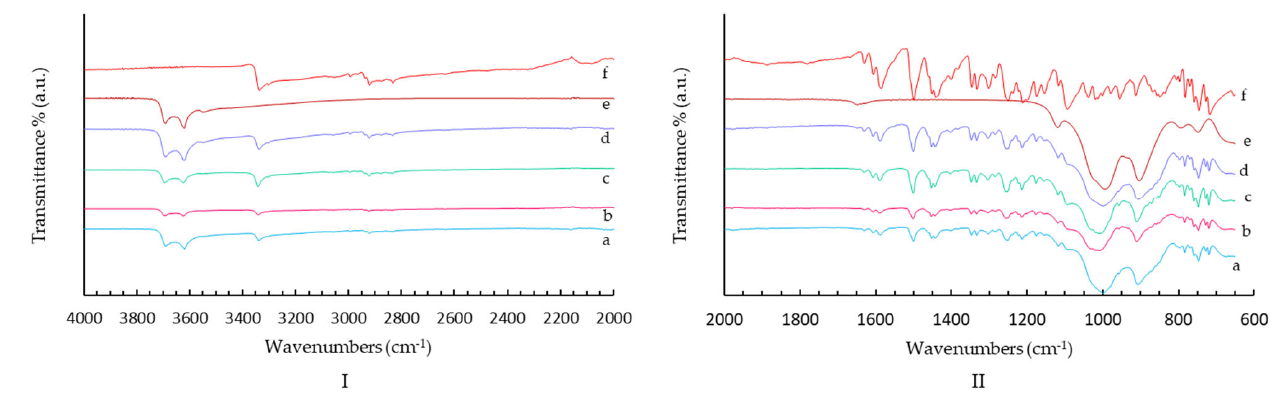
Figure 4. FT-IR spectra of CH_NaOH_0.5M (a), CH_H2SO4_0.5M (b), CH_HCl_8M (c), CH (d), H (e), and C (f) in 4000–2000 cm − 1 ( I ) and 2000–600 cm − 1 ( II ) wavenumber ranges.